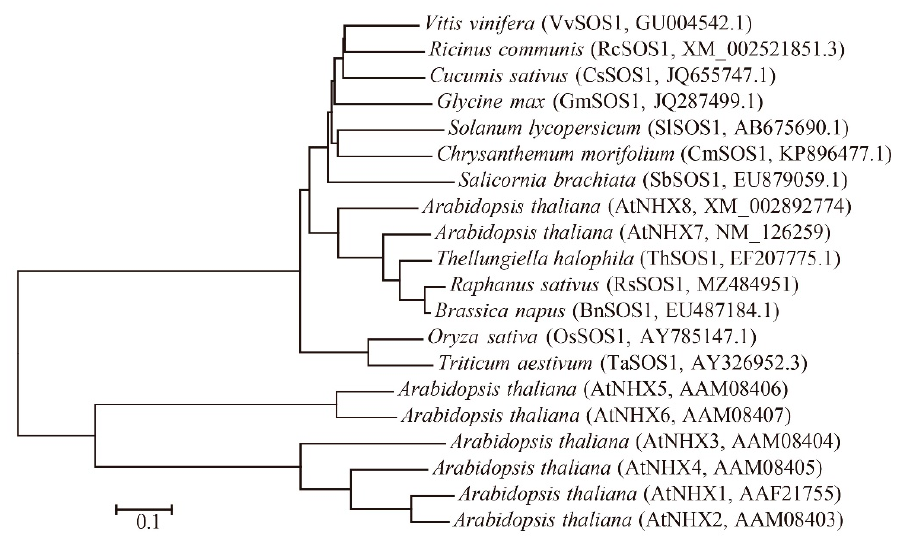
Figure 1. Phylogenetic analysis of Na + /H + antiporters in different species.